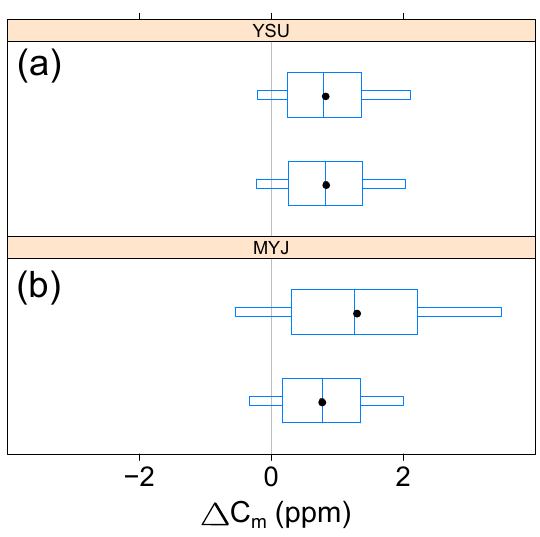
Fig. 6. Box and whisker plot of 1C m for monthly averaged mean ML CO 2 for YSU (a) and MYJ (b) at 12:00UTC. All grid cells were included in the boxplot where the diagnosed PBL top was higher than 600m in both simulations. The upper boxes represent the differences of mean CO 2 integrated over the offline diagnosed MH (VH96 Eq. 1, Ri c = 0 . 25) and the mean CO 2 integrated over 300m (within the well mixed part of the ML). The lower boxes show similar differences but using online diagnosed WRF PBL top and the 300m height. The whiskers denote the central 90% of the data points, the boxes the central 50%, the vertical lines within the boxes are the median and the black dots represent the